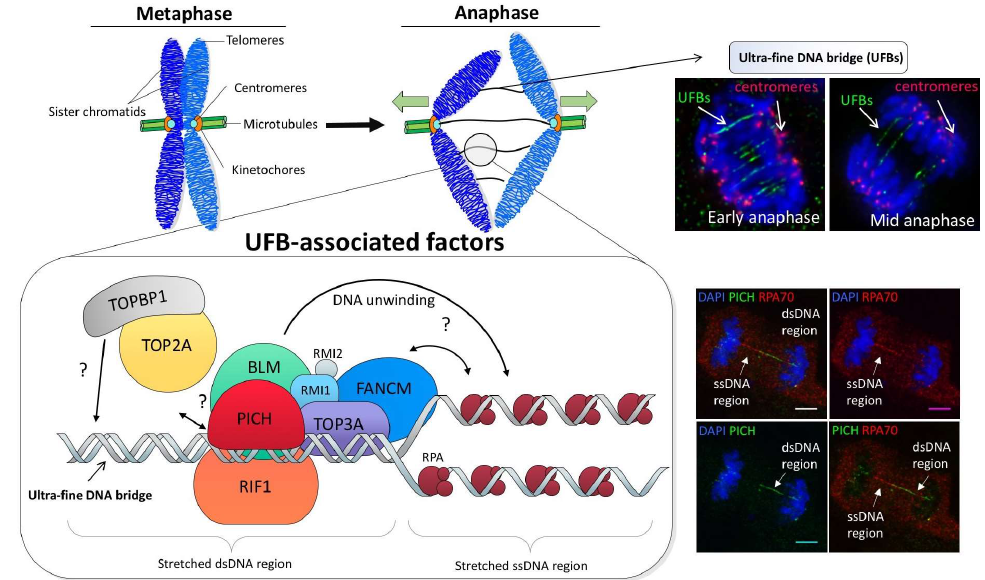
Figure 3. A proposed model of the assembly of the ultra-fine DNA bridge (UFB)-associated factors on UFB structures. ( Top ) Schematic representation of the formation of ultra-fine DNA bridges, which connect sister chromatids together in anaphase. The right image panel shows early and mid anaphase cells displaying ultra-fine DNA bridges (unpublished images). ( Bottom ) At the onset of anaphase, DNA molecules that intertwine sister chromatids are under the spindle pulling tension. The stretching forces may cause DNA conformational changes and hence initiates the binding of PICH translocase to the double-stranded DNA (dsDNA) region of the UFB. The BLM/TOP3A/RMI1-2 (BTR) complex and RIF1 protein are also recruited, respectively, probably by protein-protein interactions with PICH through its different domains. The BLM helicase subsequently unwinds the DNA duplex into single-stranded DNA (ssDNA), which allows the loading of replication protein A (RPA). In parallel, FANCM translocase is also recruited in a BLM-dependent manner. A sub-region of a sub-set of UFB structures is recognized by TOPBP1 in a PICH and BLM-independent manner, which may recruit TOP2A to a specific site of UFBs for decatenation. The right image panel shows the differential localization of PICH translocase and RPA70 to the dsDNA and ssDNA regions of a UFB, respectively, in an anaphase cell of GM00637 normal diploid fibroblast, scale bar; 5 µ m (unpublished